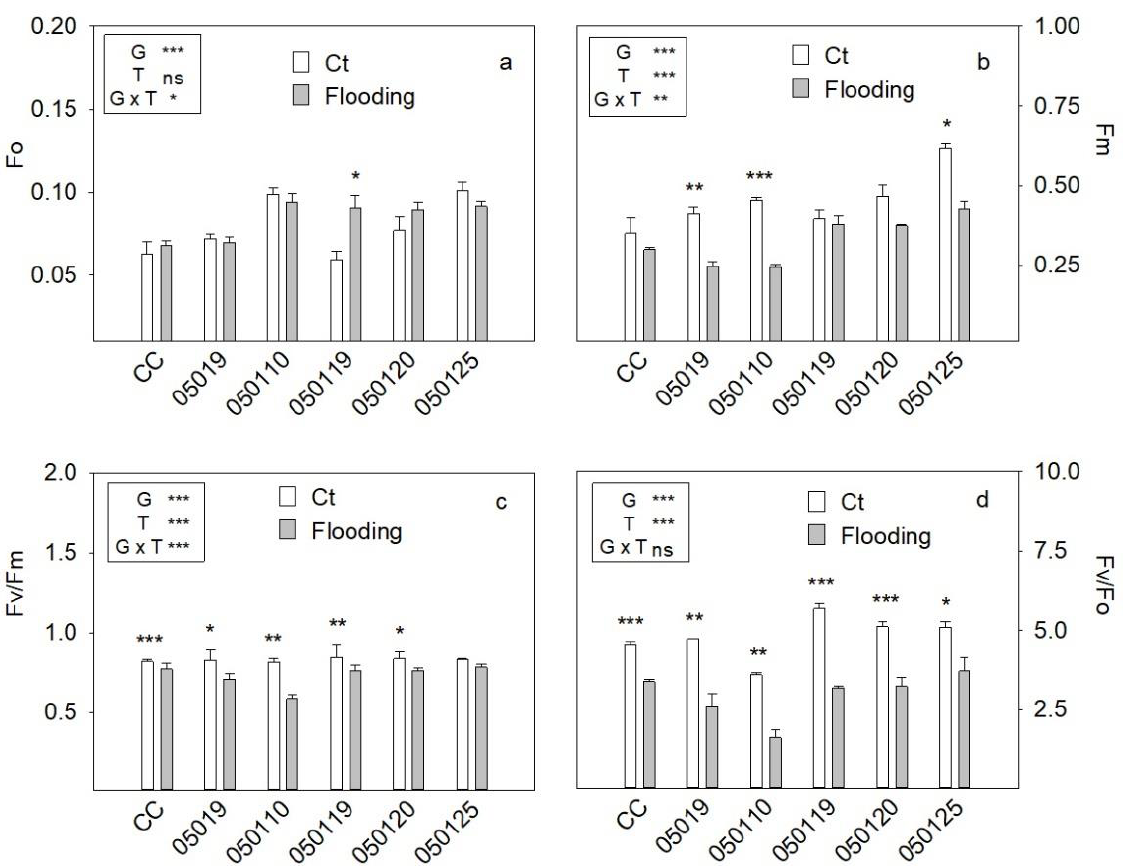
Figure 5. Fluorescence parameters ( a ) Fo, ( b ) Fm, ( c ) Fv/Fm, and ( d ) Fv/Fo) in young and well-developed (fully expanded) leaves of five citrus hybrids grown for 35 days in the non-stressed (Ct) or flooding treatment. Values are the means of six independent seedlings ( n = 6). In each hybrid, comparisons among treatments were made by Fisher’s least significance difference (LSD) test. * p < 0.05, ** p < 0.01, *** p < 0.001, ns: not significant. CC: Carrizo citrange; G: genotype, T: treatment.